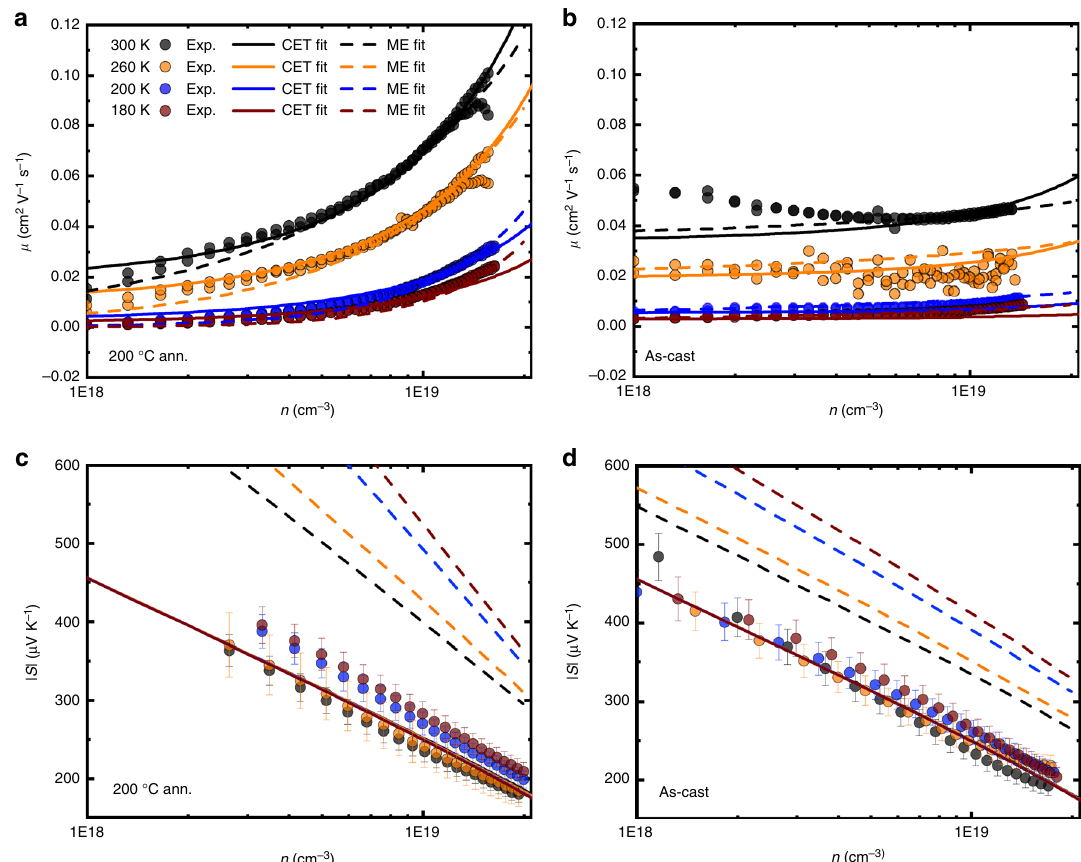
Fig. 3 Saturation mobility μ and Seebeck coef fi cient S versus charge carrier density n . Charge carrier density and temperature dependent saturation mobility as well as Seebeck coef fi cient measurements of the 200 °C annealed ( a , c ) and as-cast device ( b , d ). The fi ts of the Coulomb enhanced charge transport (CET) model 21 (solid lines) and the ME model 5 (dashed lines) are shown as well. The fi tting parameters for the CET fi ts are E barr = 95 meV, 2 V − 1 s − 1 , n = 2 × 10 20 cm − 3 ( a – d ) and G = 80 meV, μ μ ¼ 20 (cid:4) 300 = 0.75 cm 2 V − 1 s − 1 ( a , c ), respectively G = 120 meV, μ = 1.35 cm 2 V − 1 s − 1 0 0 T cm 02C ( b , d ). The fi tting parameters for the ME fi ts are E deep = − 8 eV, W deep = 0.01 eV, E 0 = − 4 eV, E C = 0.037 eV, N tot = 2 × 10 20 cm − 3 ( a – d ) and μ 0 = 0.7 cm 2 V − 1 s − 1 , N tail = 5 × 10 19 cm − 3 , W tail = 0.042 eV, E a = 0 eV ( a , c ), respectively μ 0 = 5.2 cm 2 V − 1 s − 1 , N tail = 1.8 × 10 20 cm − 3 , W tail = 0.018 eV, E a = 0.04 eV ( b , d ). The relative error in the Seebeck coef fi cient is approx. 7%, calculated from the intrinsic current and voltage measurement errors of the Agilent SPA 4156B as well as the linear regression fi t errors from the sensor resistance calibration and the thermal voltage versus temperature difference plots (shown as error bars on the data